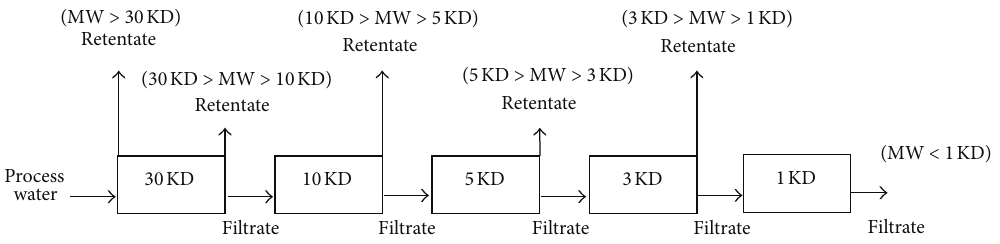
Figure 1: UF serial processing scheme.